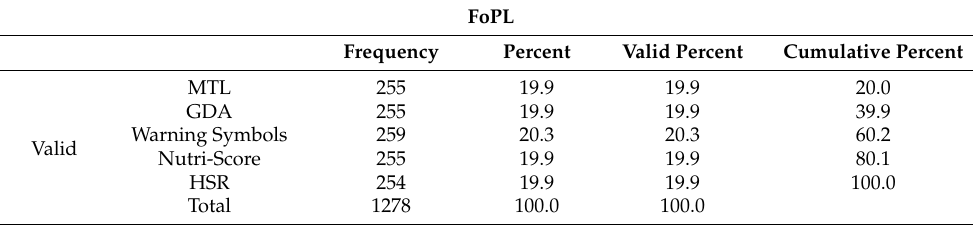
Table 2. Sample distribution across